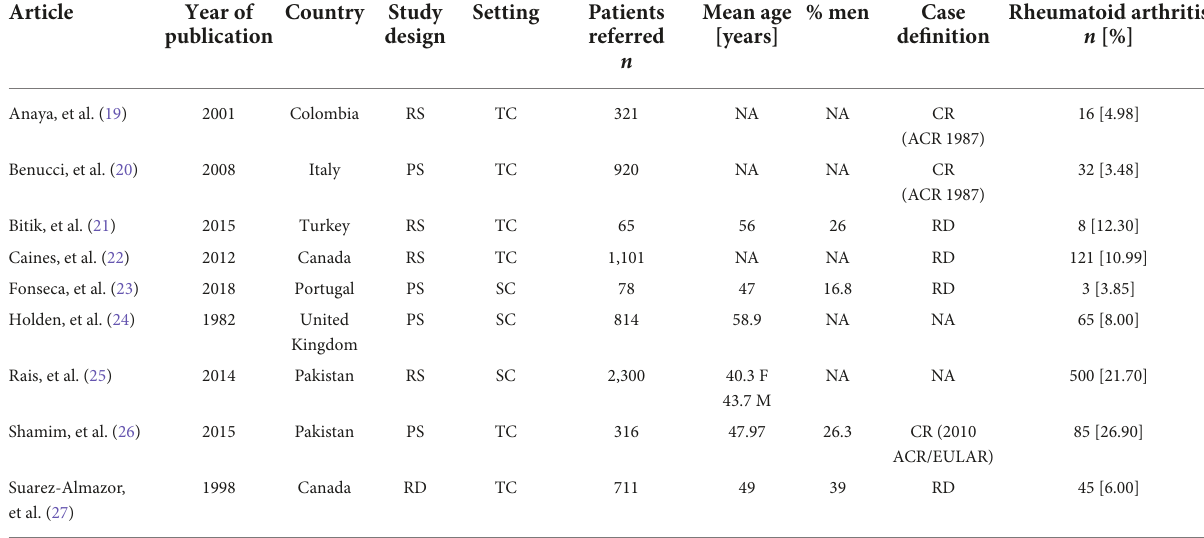
TABLE 1 Study characteristics of included studies.